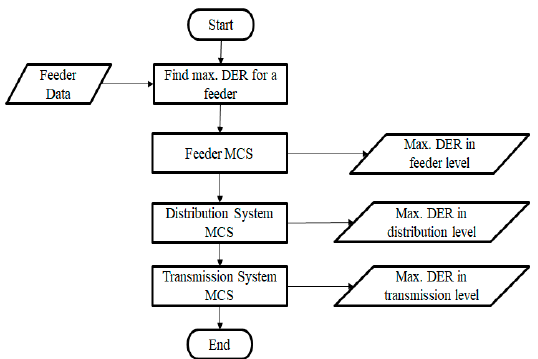
Figure 3. Proposed algorithm to increase the hosting capacity of the DER in the power system.